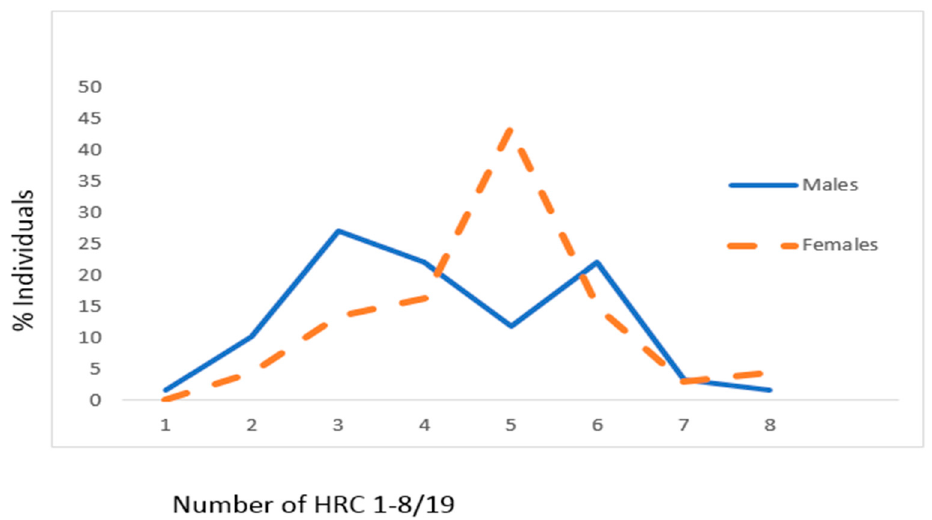
Figure 4. Frequencies of homozygous recessive characteristics (hrc) in males and females of the CAD sample with HTN. X—mean values with standard deviation, V—variability, z—Mann Whitney U test. Males: n = 59, x hrc/19 = 4.20 ± 1.55 (95% CI 3.80–4.61). Females: n = 67, x hrc/19 = 4.78 ± 1.32 (95% CI 4.45–5.10; z = 2.075, p = 0.038). V Males = 36.90%, V Females = 27.62%.